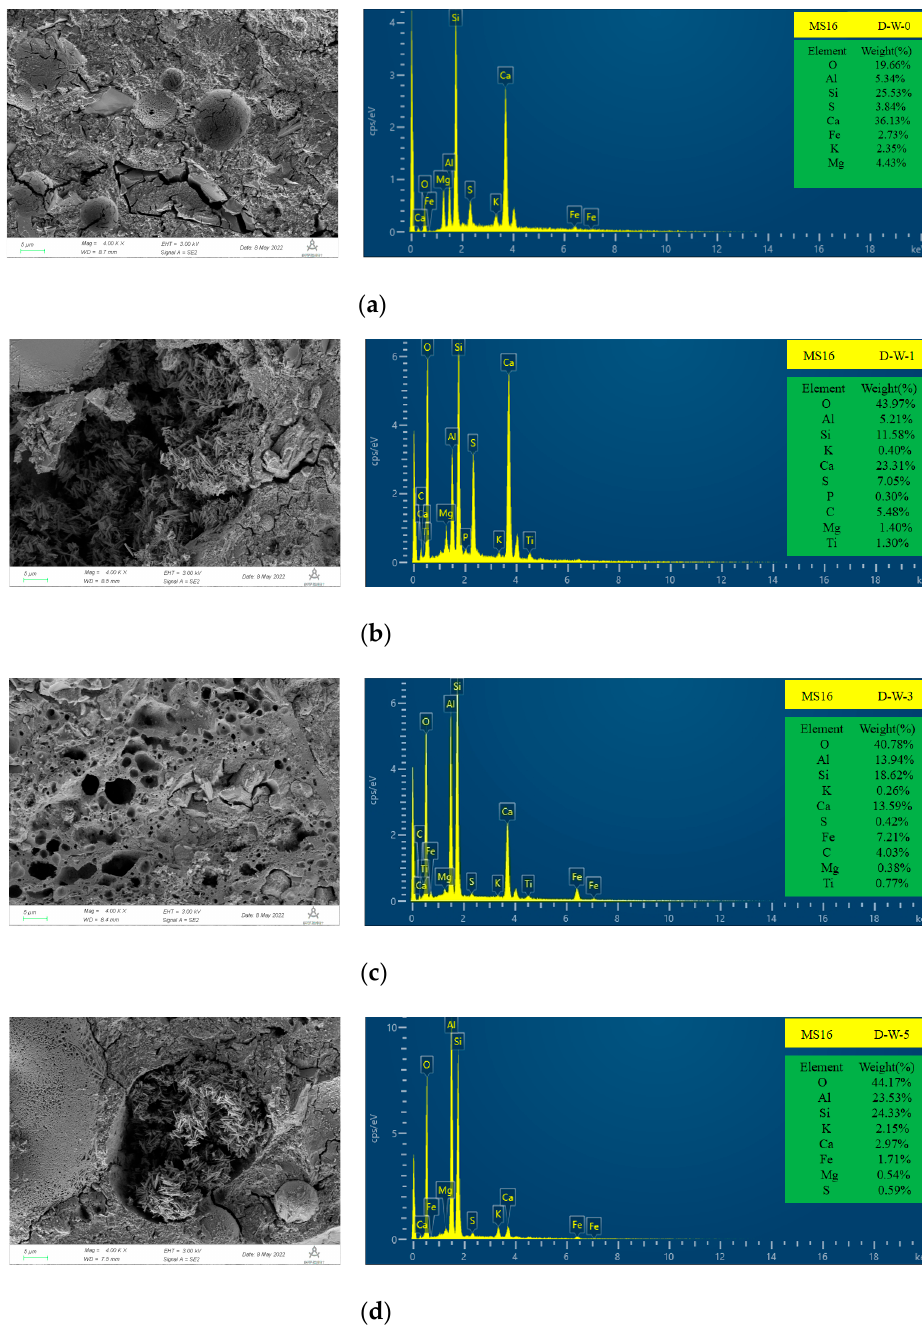
Figure 10. The SEM and EDS semi-quantitative spectrogram of MS16 sample. ( a ) D-W-0. ( b ) D-W-1. ( c ) D-W-3. ( d ) D ‐ W ‐ 5.